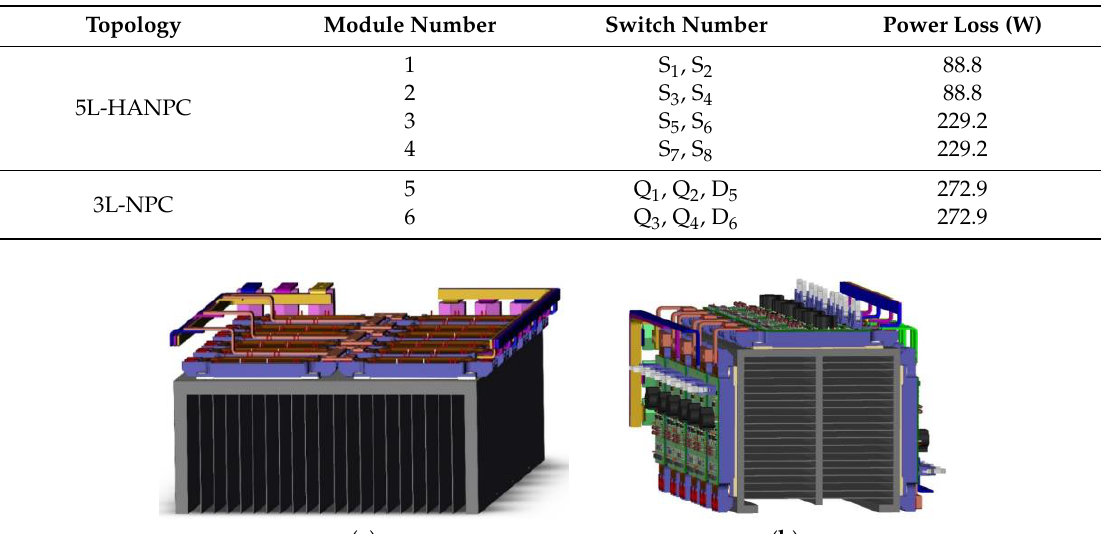
Table 5. Theoretical power losses on all IGBT modules.